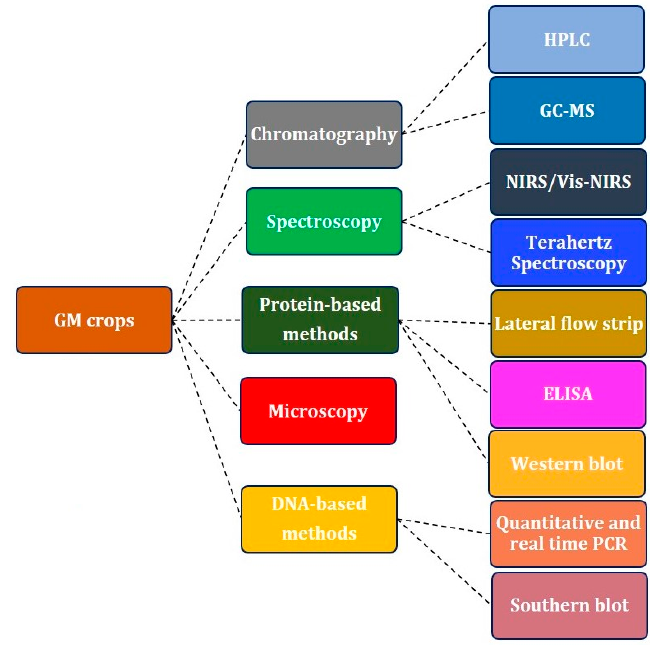
Figure 1. Conventional methods for the identification of GMOs.